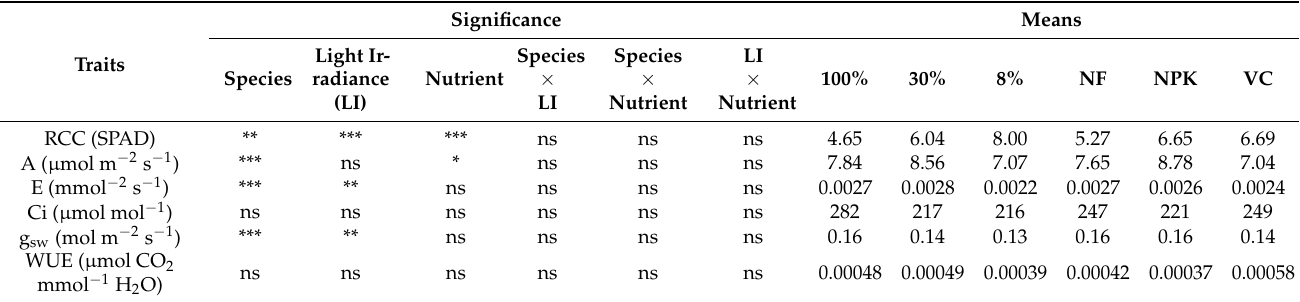
Table 2. The effects of light irradiance and nutrient amendments on physiological characteristics in two Shorea species.